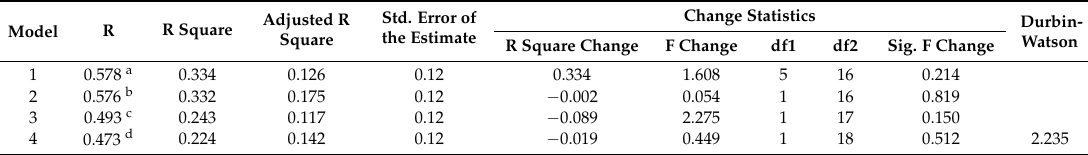
Table 9. Regression analysis statistics and models’ summary among multiple spectral indices and log-chlorophyll- a concentrations (dependent variable).